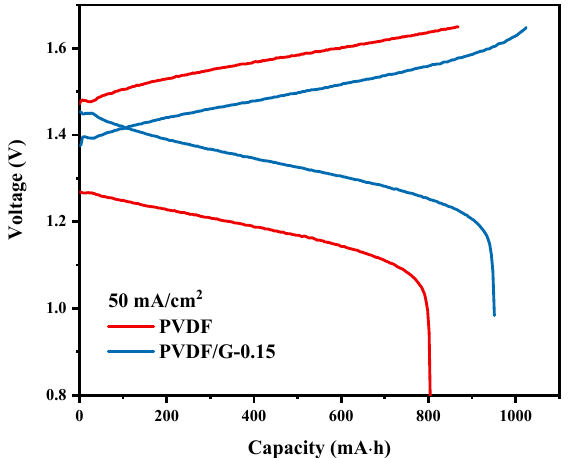
Figure 6. Charge-discharge curves of the VFB single battery assembled with PVDF and PVDF/G-0.15 membranes.